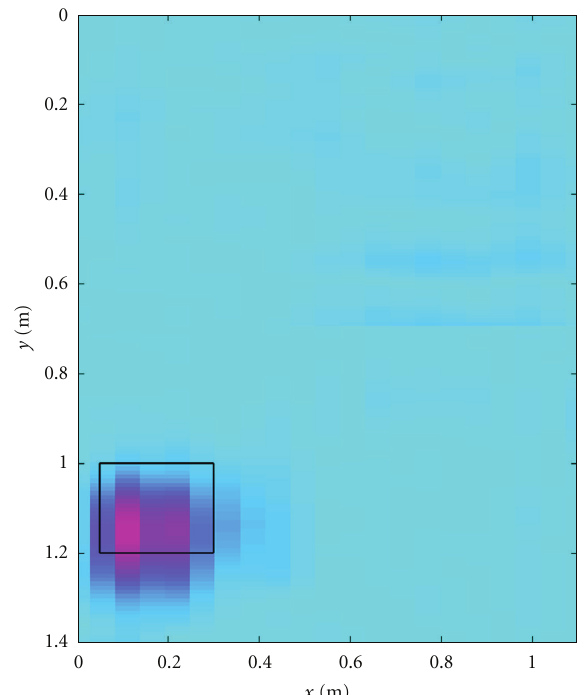
Figure 7: Constant depth slice at the depth of about 50cm, achieved from